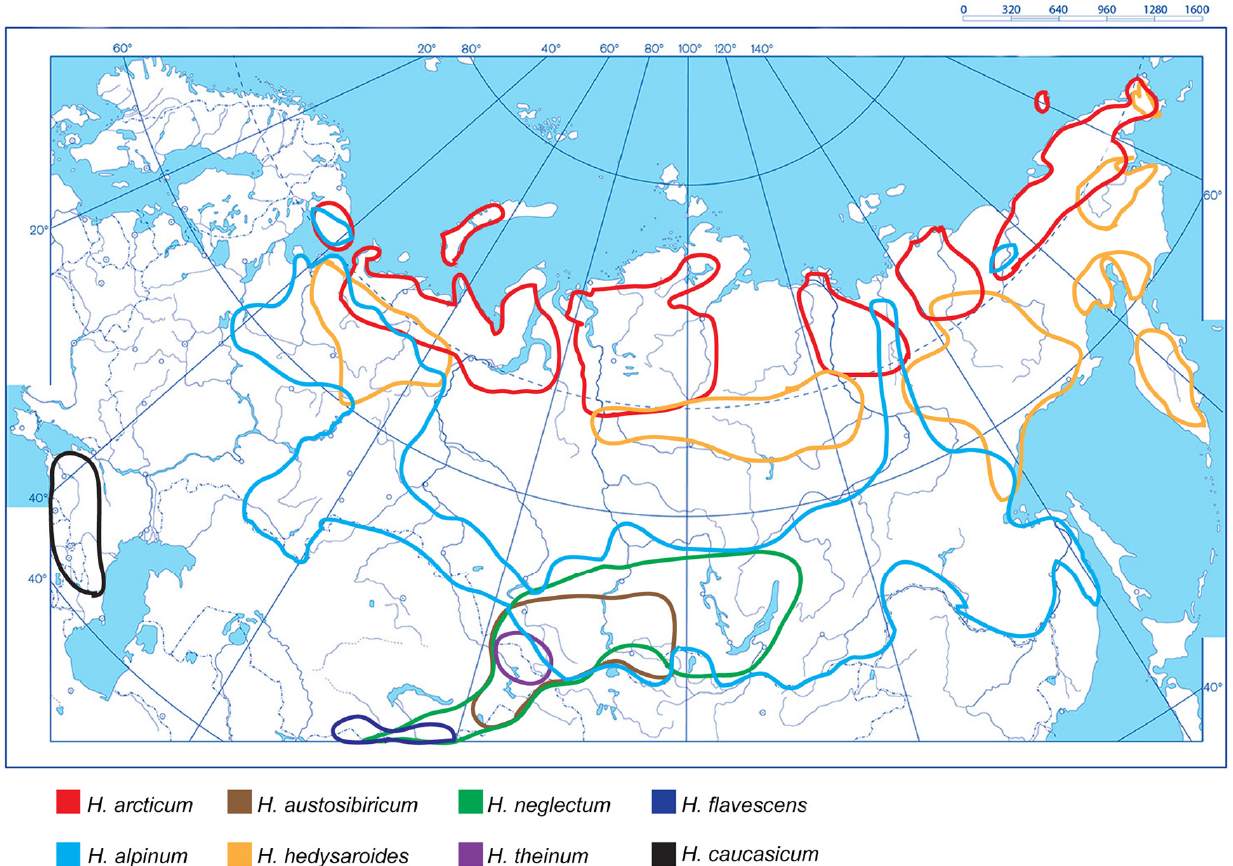
Figure 1. An integrated schematic map showing distribution of H. alpinum , H. arcticum , H. austrosibiricum , H. caucasicum , H. flavescens , H. hedysaroides , H. neglectum and H. theinum within the northern, central and eastern parts of Eurasia. The species names and correspondent colours of the lines indicating the boundaries of the species occurrence are specified under the